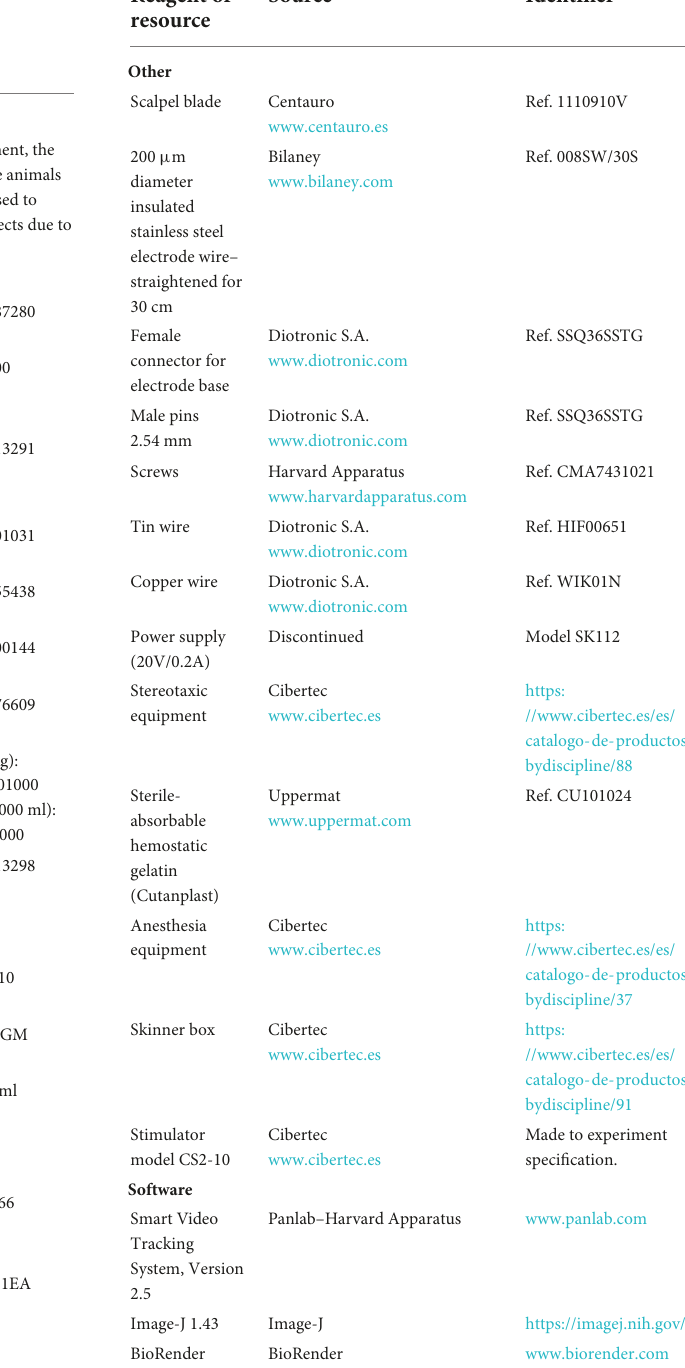
TABLE 1 Description of all reagents (subjects, chemicals, solution preparations, other relevant tools, and software) used in this protocol with their corresponding source and